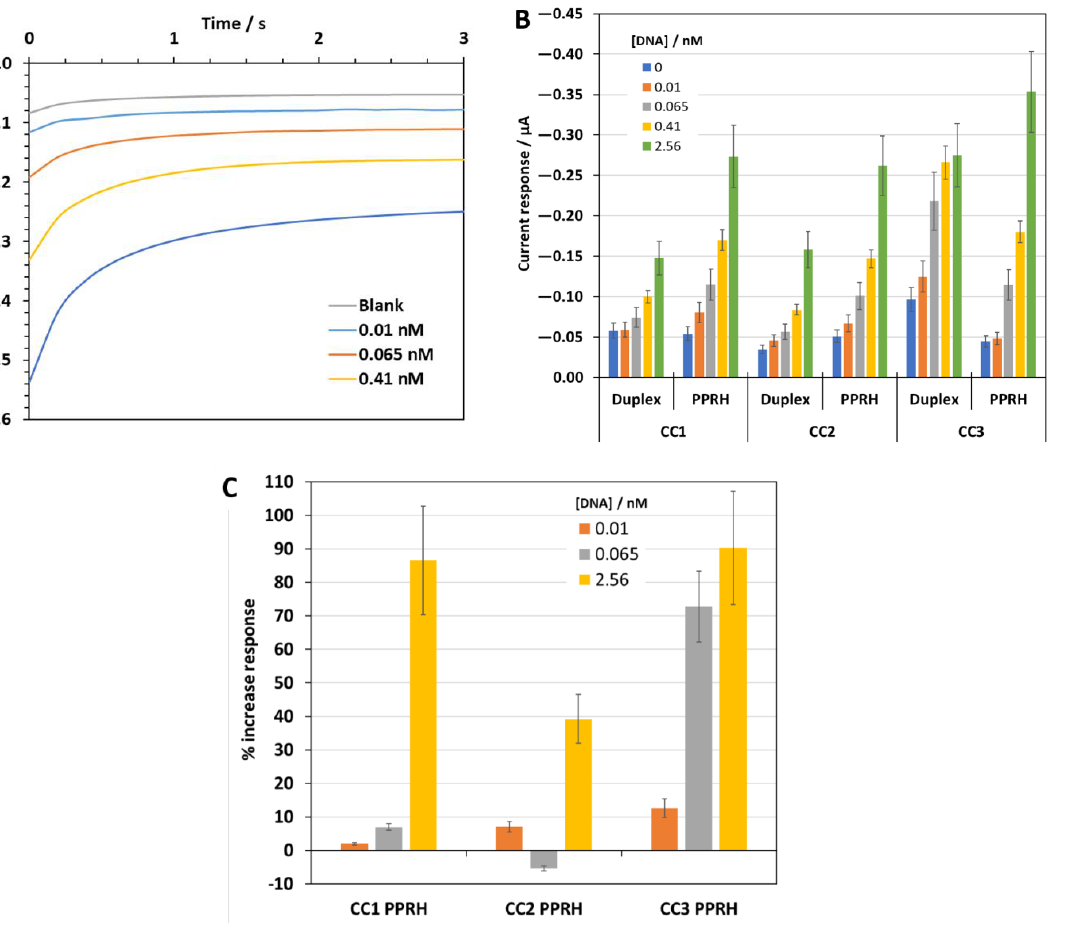
Figure 8. ( A ): Current response profiles to different concentrations of the target DNA CC1 sequence in hybridization buffer using the MNPs modified with PPRH — CC1. ( B ): Analytical signal values recorded with the three different capture probes, CC1, CC2, and CC3, in a duplex and PPRH format for different concentrations of the corresponding oligonucleotide target DNA sequences in hybrid- ization buffer. ( C ): Increase in response relative to the blank response (in %) recorded in the UTM from Biocomma with the PPRH — CC1, CC2, and CC3, respectively, for three of the tested oligonu- cleotide concentrations. Standard deviation of three replicates carried out consecutively is drawn as error bars.